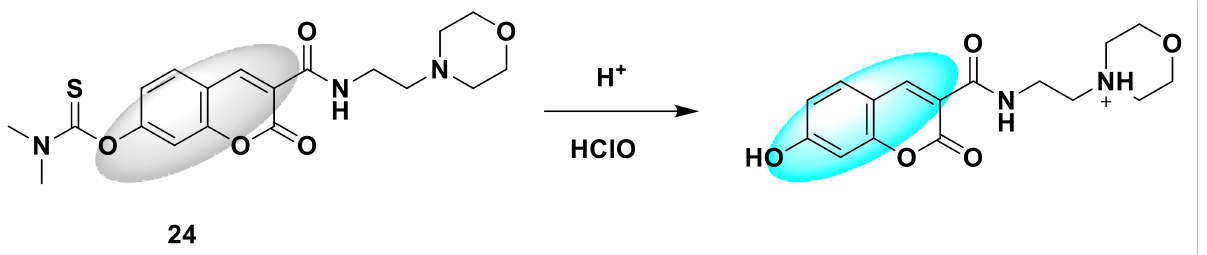
Figure 24. The reaction of probe 24 and HClO.